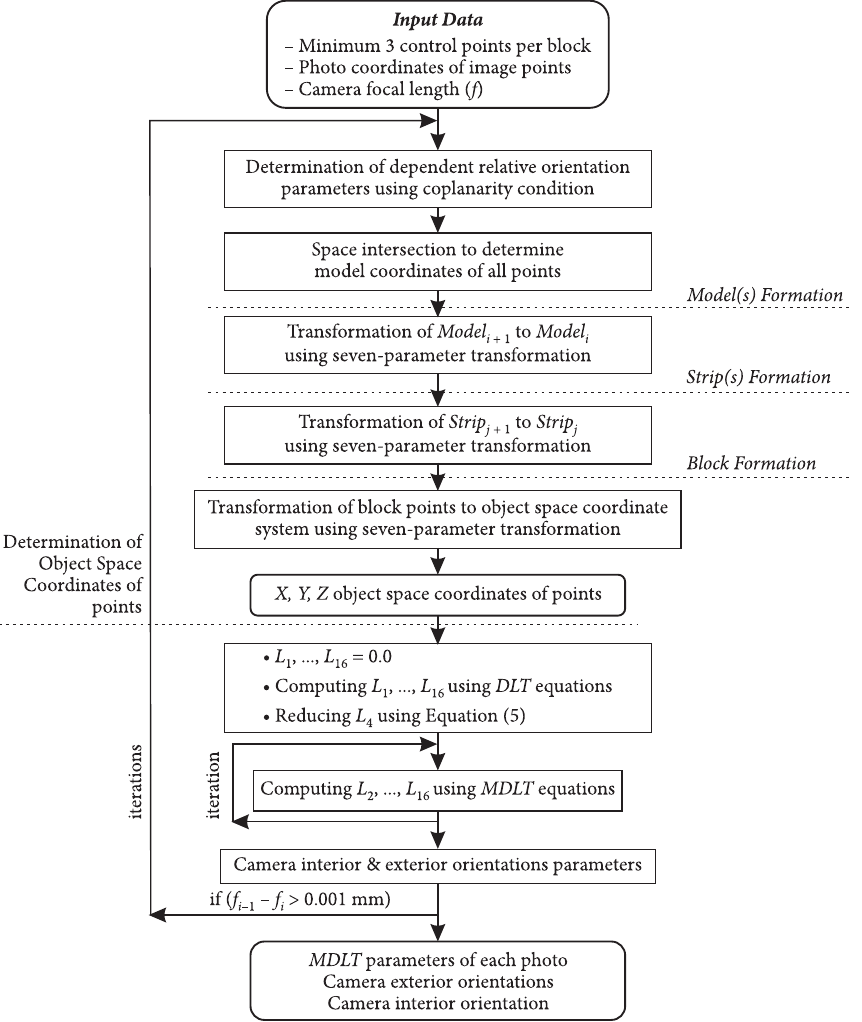
Figure 1. Computation of the initial values of object space coordinates of points, MDLT parameters and camera interior and exterior